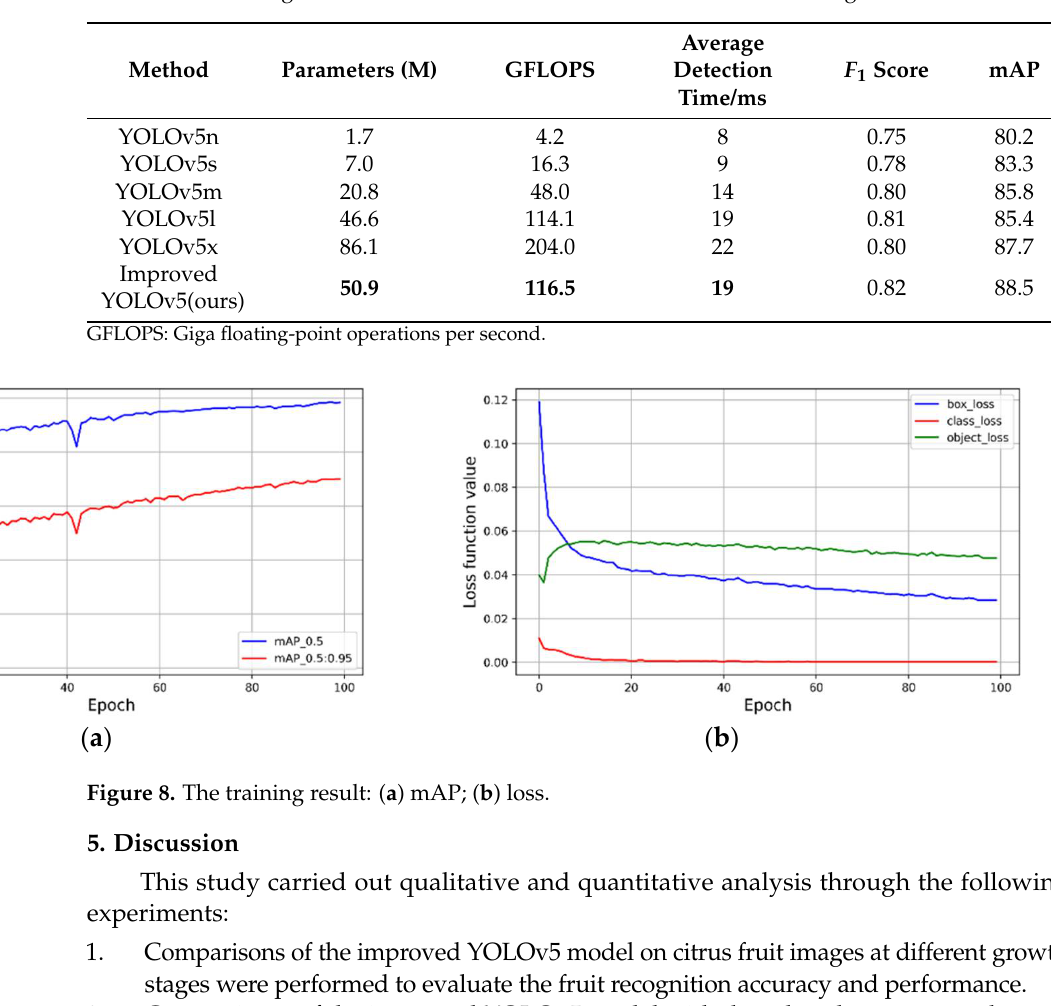
Table 3. The training results of each version of the YOLOv5 model on the original dataset.